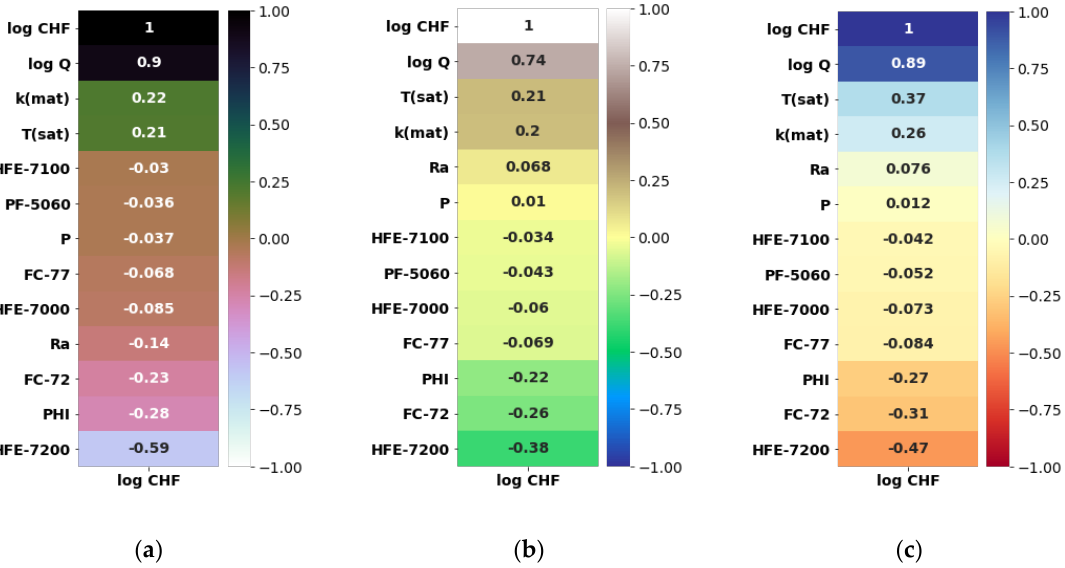
Figure 5. Correlating CHF data of water with categorical variables: ( a ) Pearson correlation, ( b ) Ken- dal correlation, and ( c ) Spearman correlation.